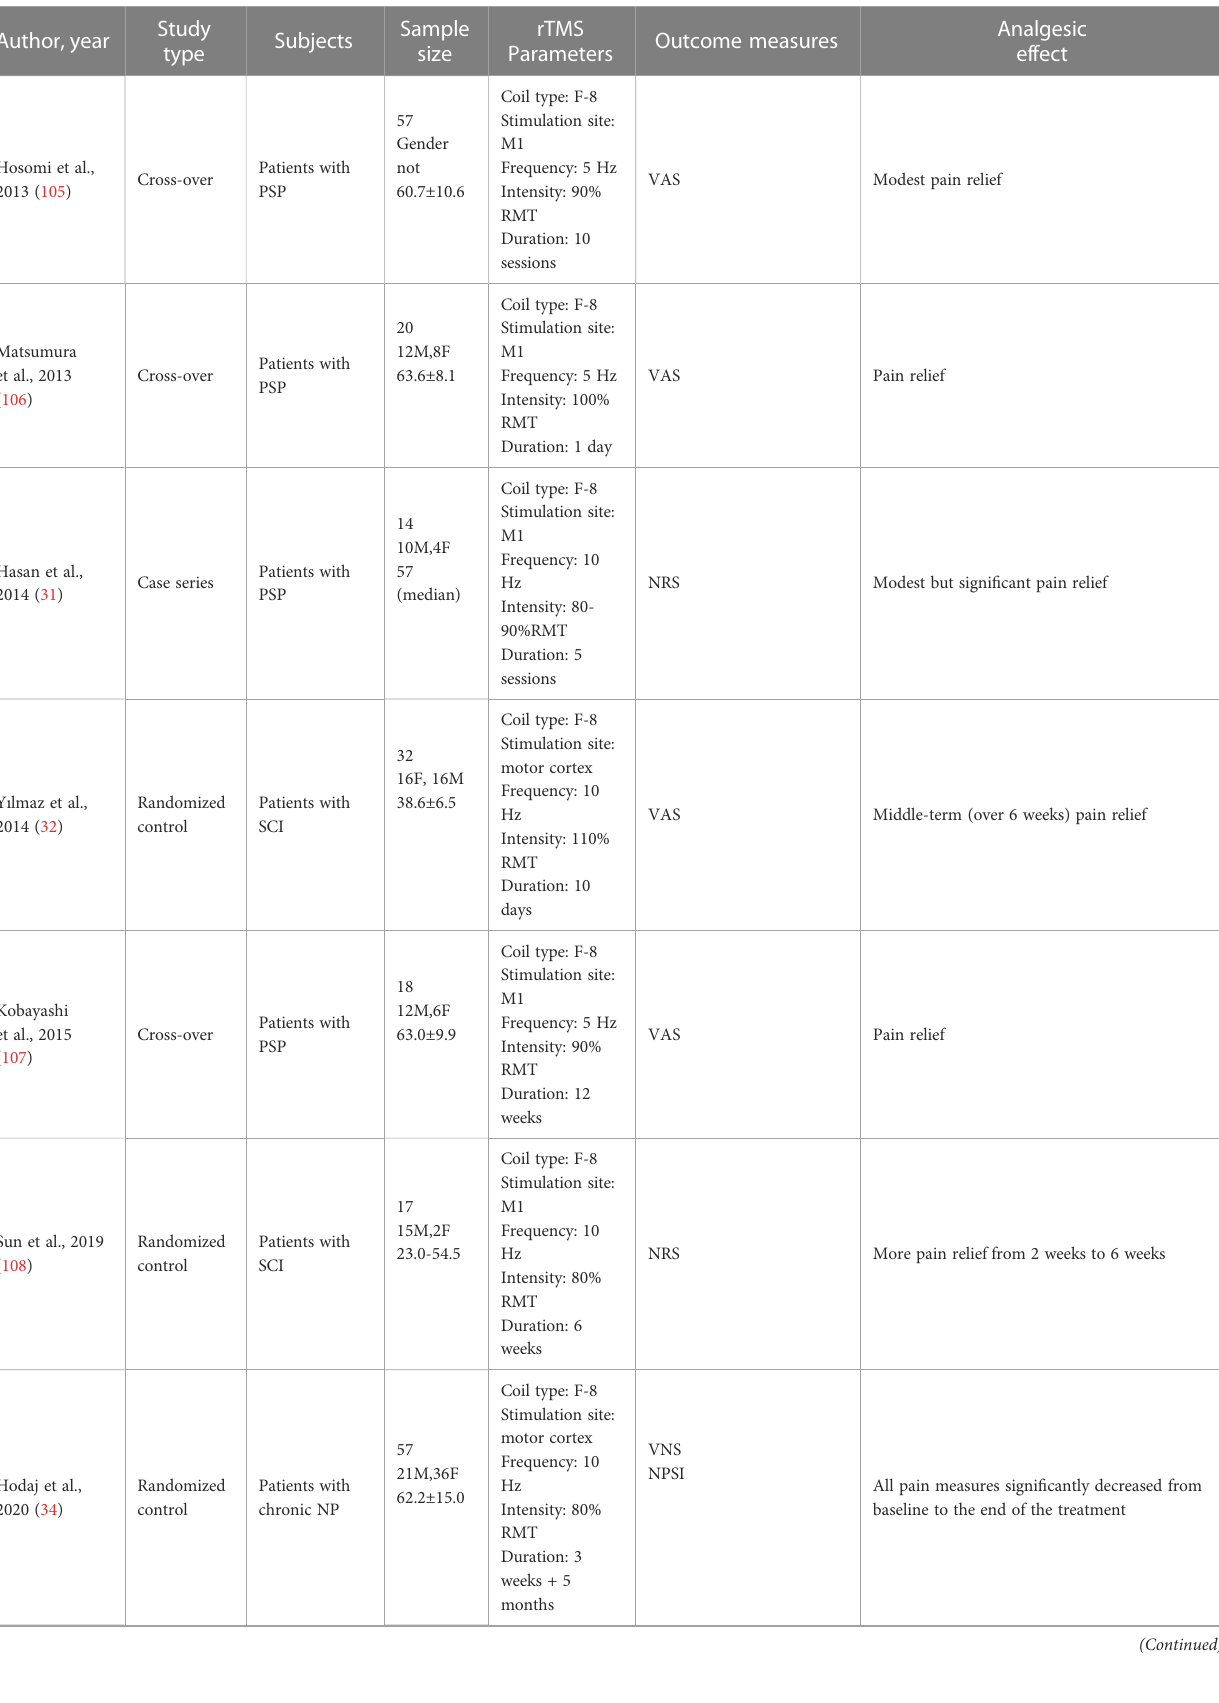
TABLE 1 Major fi ndings of rTMS in neuropathic pain